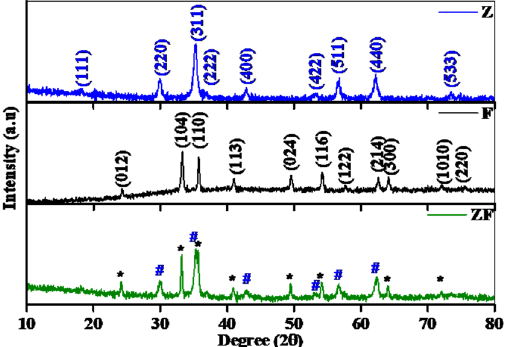
Figure 2. Phase analysis of ZnFe 2 O 4 (Z), Fe 2 O 3 (F), and ZnFe 2 O 4 -Fe 2 O 3 (ZF) nanostructures. SEM analysis of synthesized ZnFe 2 O 4 (Z), Fe 2 O 3 (F), and ZnFe 2 O 4 -Fe 2 O 3 (ZF) nanos-